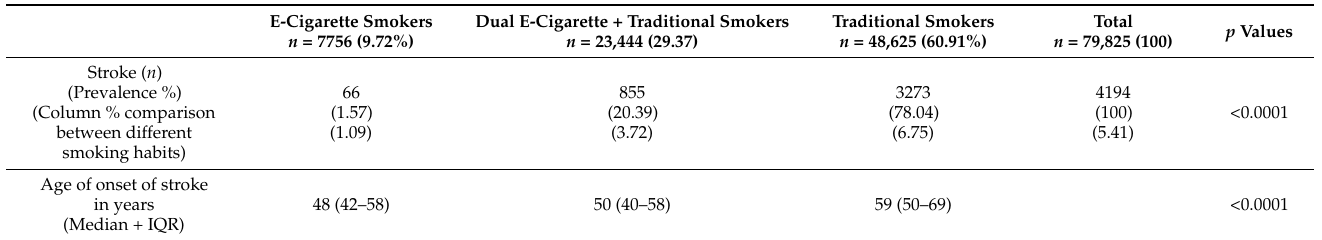
Table 1. Prevalence of stroke among various smoking habits among NHANES respondents 2015–2018 ( n = 79,825).